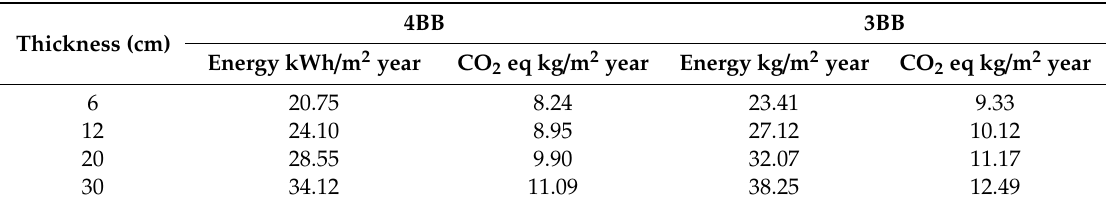
Table 9. Embodied cradle-to-grave impacts of the building components: primary energy and CO 2 equivalent emissions for 4BB and 3BB with various insulation thicknesses.